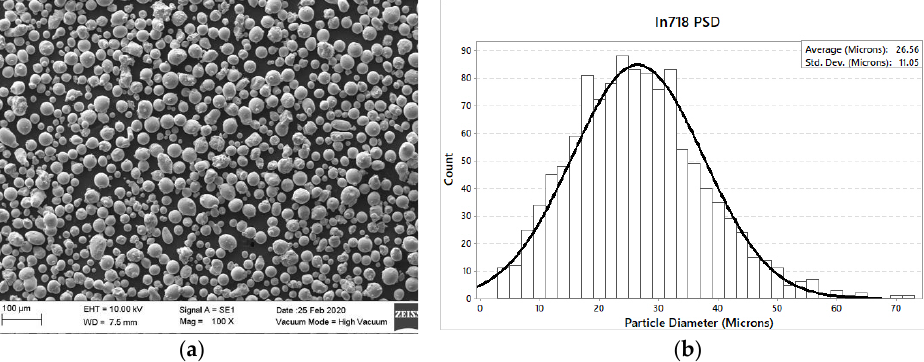
Figure 1. Praxair’s TruForm In718 powder’s ( a ) scanning electron microscopy image and ( b ) particle size distribution.